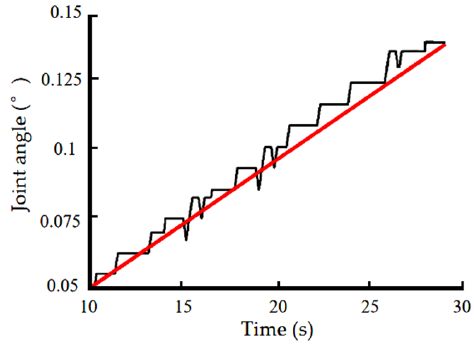
Figure 8. Angle position tracking curve.